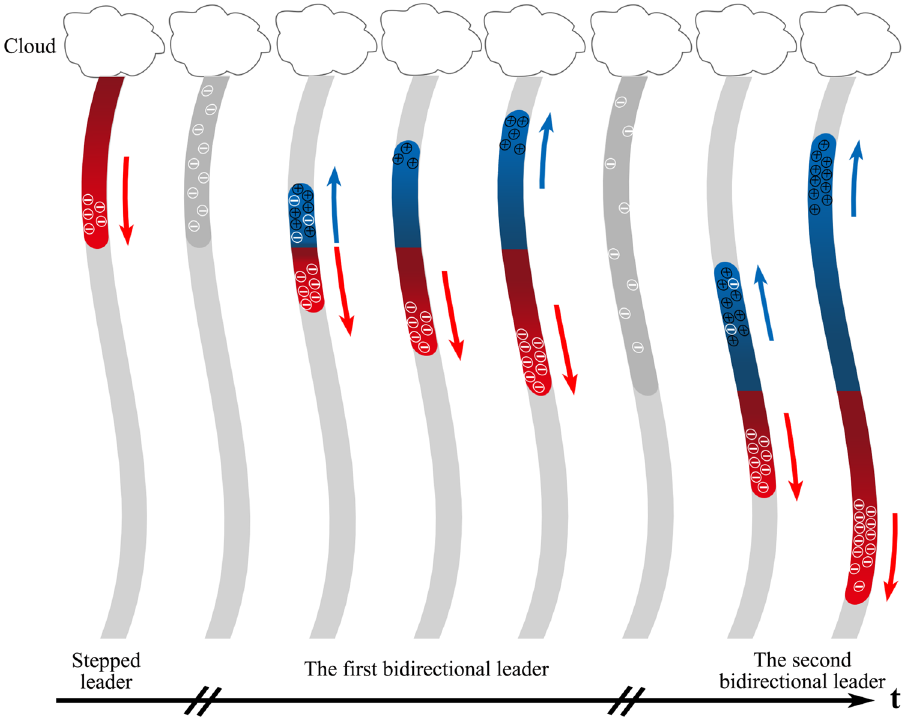
Figure 5. Bidirectional leader development mode. Gray part indicates residual channels. Red part indicates the negative leader, and blue part indicates the positive leader. The darker part of the leader is the plasma